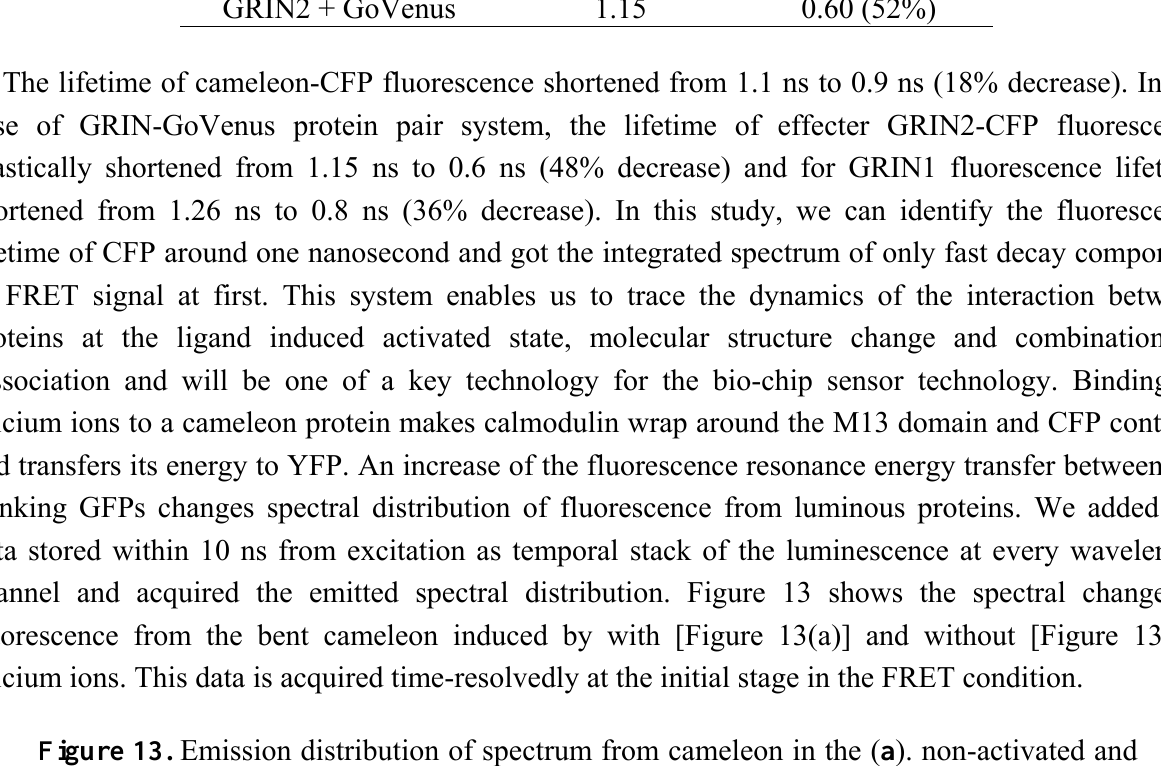
( b ). FRET condition using this time resolved FRET system. Fluorescence from CFP and YFP protein is shown by the